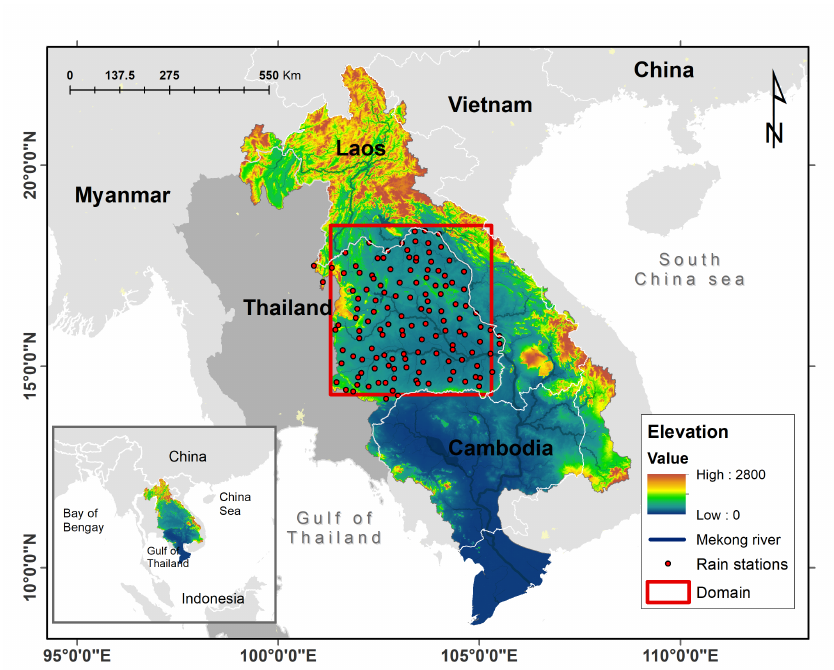
Figure 1. Digital elevation of the Lower Mekong Basin in Thailand. Red rectangle corresponds to the study area in the Isan region. Red dots represent the hourly rain gauge stations from www.thaiwater.net. Blue line represents the Lower Mekong river